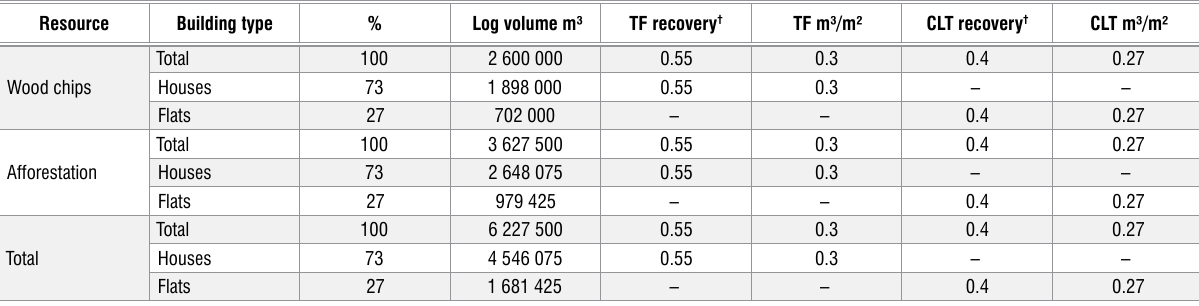
Annual sustainable log resource potential and wood-based development coefficients for South Africa for timber frame (TF) and cross-laminated timber (CLT)